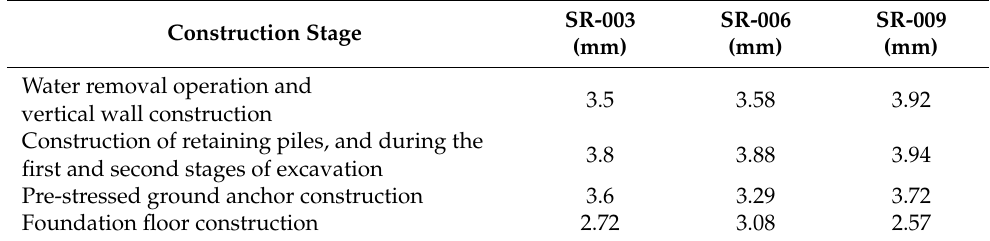
Table 2. Subsidence monitoring data of the railway track (SR) in each construction stage in the south